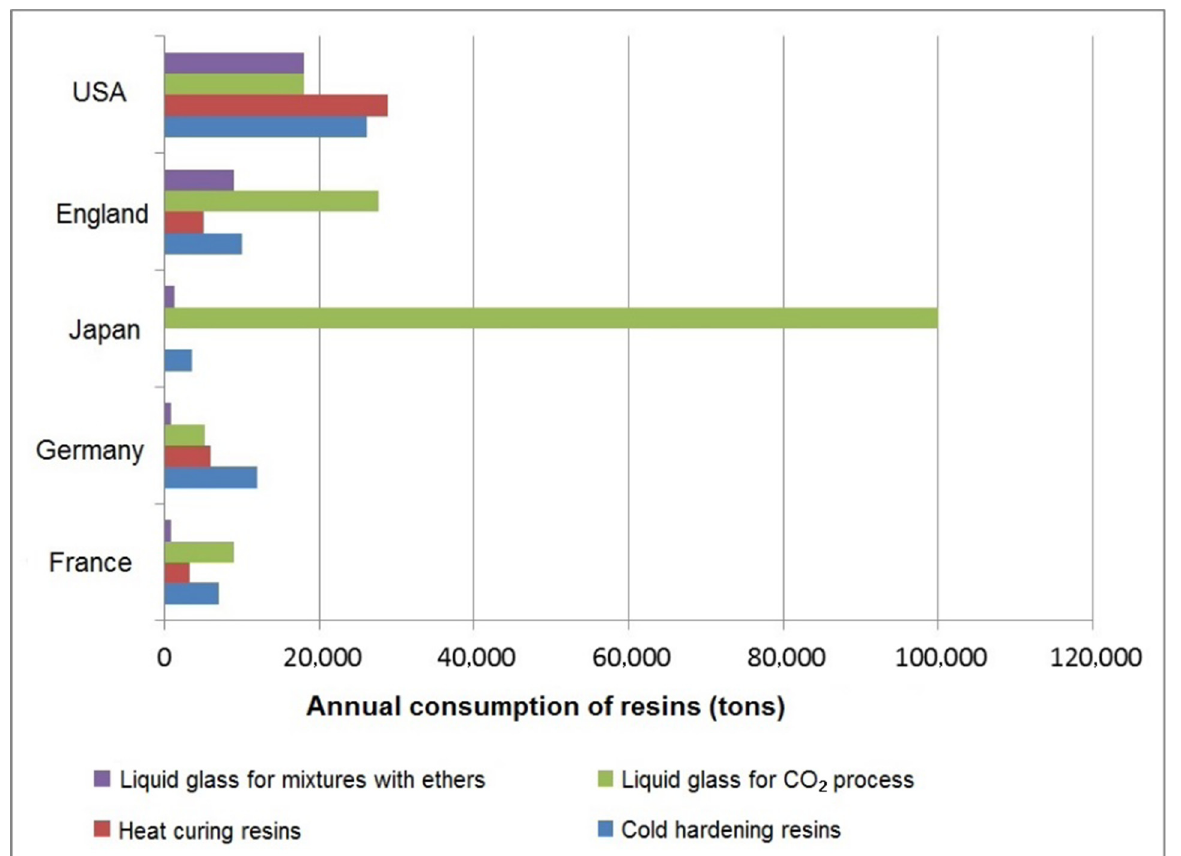
Figure 1. Annual binder consumption in different countries with well-developed foundry production, in tons.